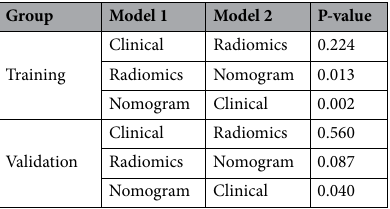
Table 4. Comparison of the prediction with the radiomic nomogram, radiomics algorithm, and the clinical model.